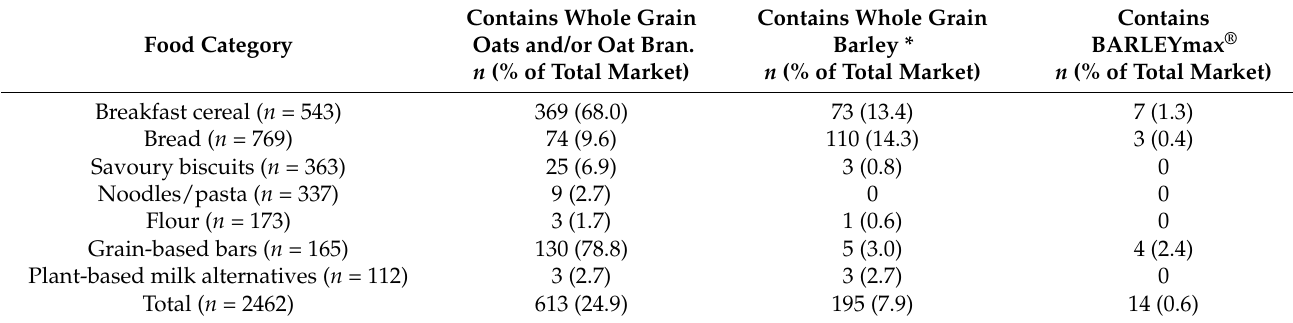
Table 2. Number and proportion of food and beverage products made with whole grain oats and/or oat bran, whole grain barely and BARLEYmax ® , per